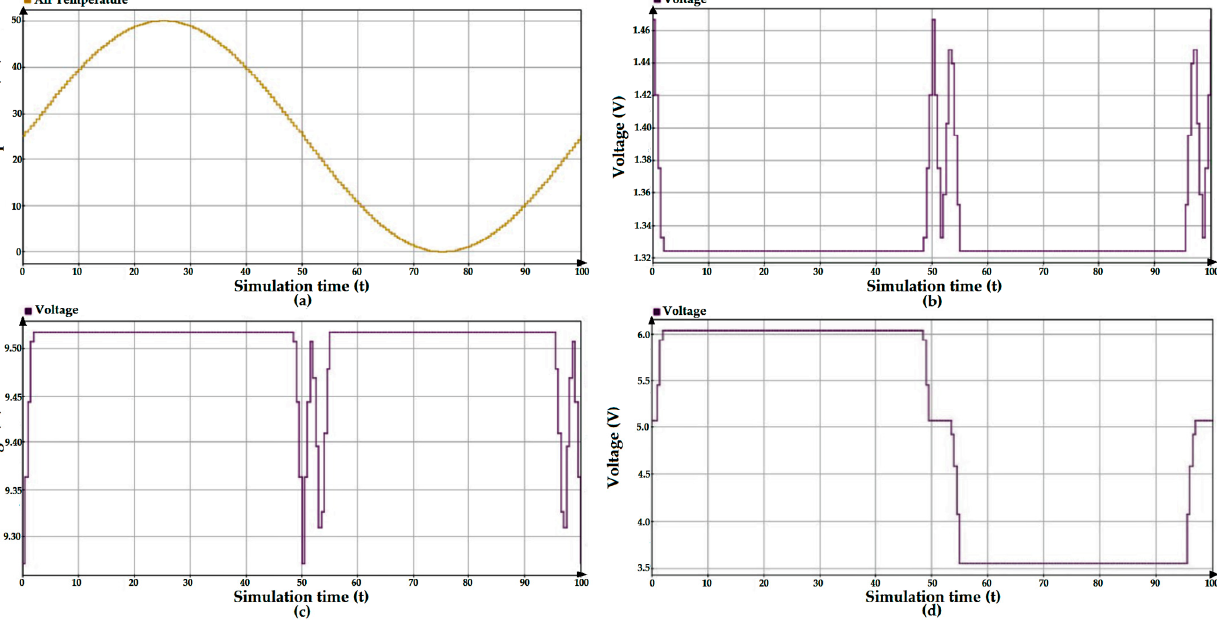
Figure 14. ( a ) Air temperature vs. time; ( b ) voltage vs. time at minimum water need; ( c ) voltage vs. time at maximum water need; ( d ) voltage vs time at standard operating conditions.